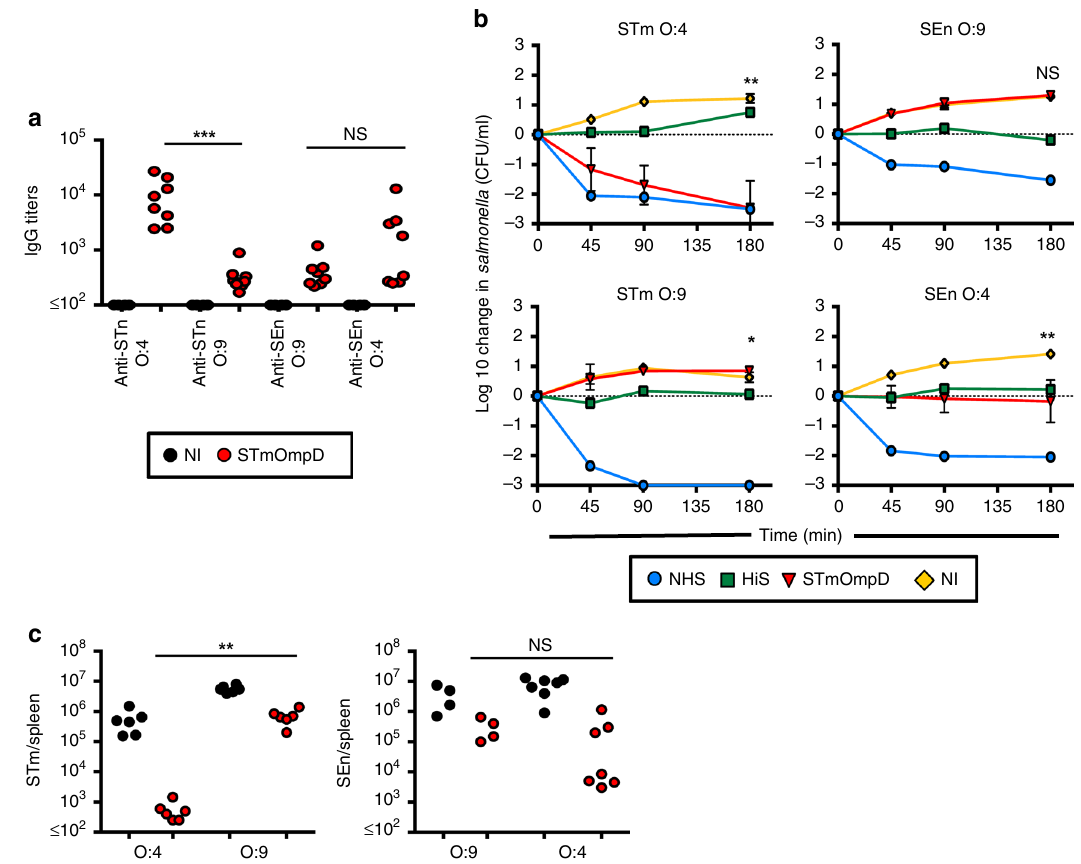
Fig. 5 O-Ag structure and variability in fl uence access of antibody to OmpD. a IgG titers to STm and SEn WT and LPS chimera strains were assessed using sera from NI mice and mice immunized with STmOmpD as in Fig. 1a. Each point represents the titers from one mouse. Representative of three experiments. b Serum bactericidal assays using STm D23580, SEn D24954, and STm O9 and SEn O4 chimera mutants with sera from nonimmunized mice (yellow) or mice immunized with STmOmpD (red) as in Fig. 1a, supplemented with human sera as a complement source with anti-STm-speci fi c antibodies depleted. Normal human serum (NHS, blue) and heat-inactivated human serum (HiS, green) were used as controls. Negative values correspond with a decrease in viable STm compared with starting normals. Samples were taken at minutes 45, 90, and 180 using a starting concentration of 10 6 CFU/ml. c Bacterial burdens from the spleens of NI and mice immunized twice with 20 μ g of STmOmpD infected for 24 h with 1 × 10 5 of STm or SEn WT and O-Ag chimeras. Data are representative of a minimum of two individual experiments. * P ≤ 0.05, ** P ≤ 0.01, *** P ≤ 0.001, NS = nonsigni fi cant assessed by two- tailed Mann – Whitney U